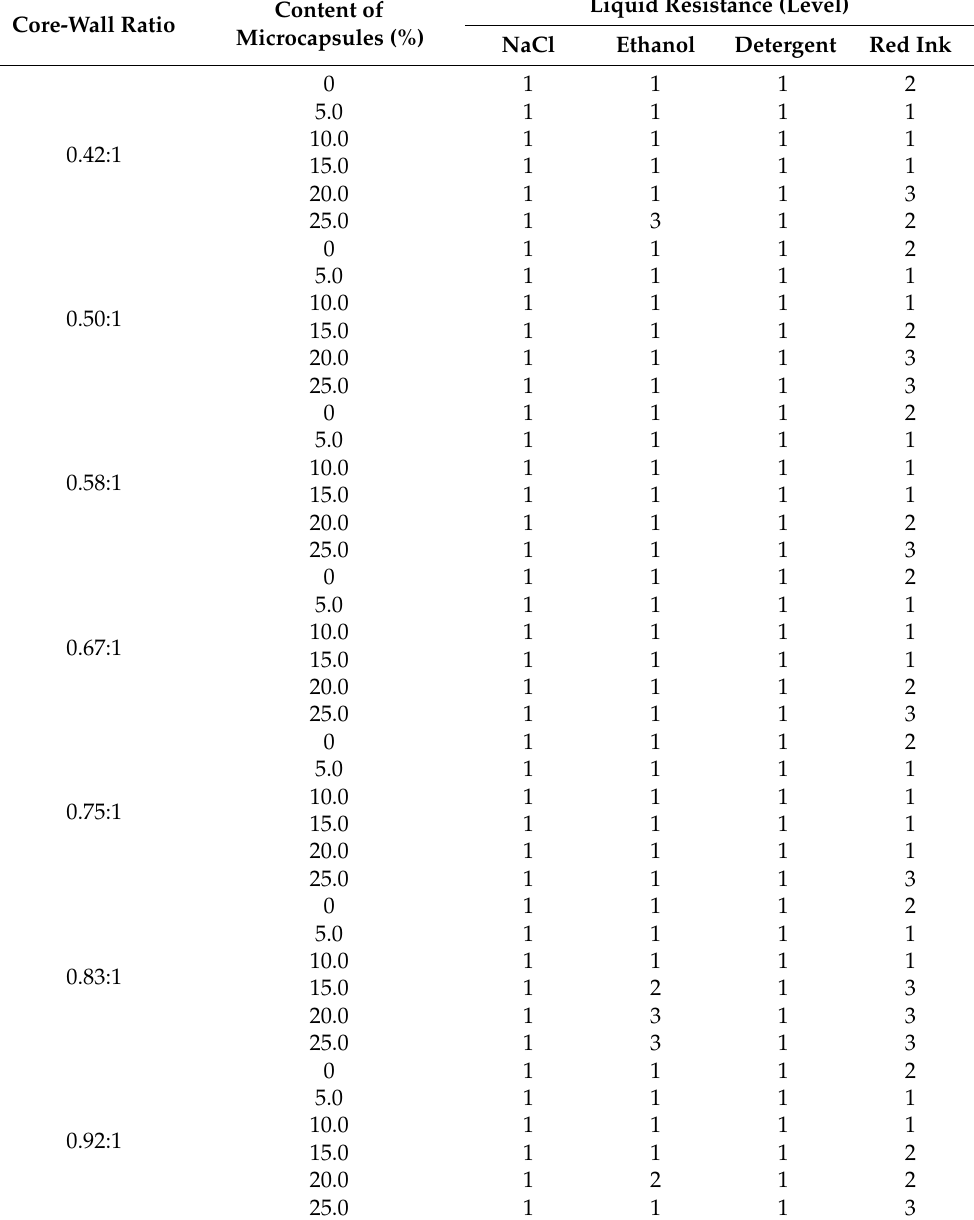
Table 7. Liquid resistance rating of water-based topcoat paint